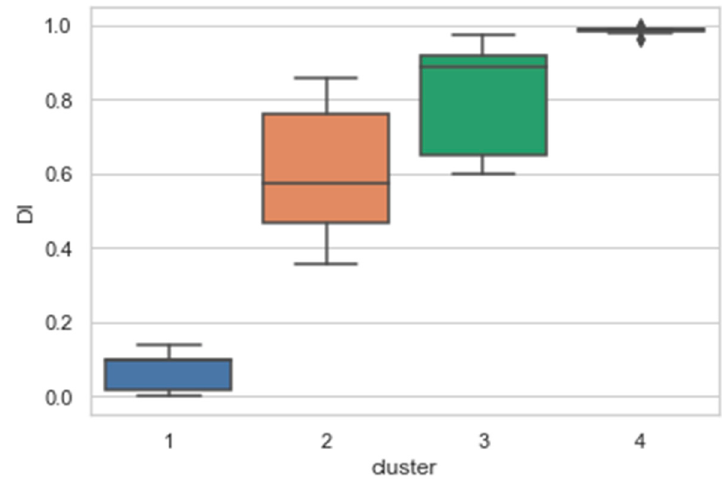
Figure 8. Results of every performance goal in four urban design clusters.